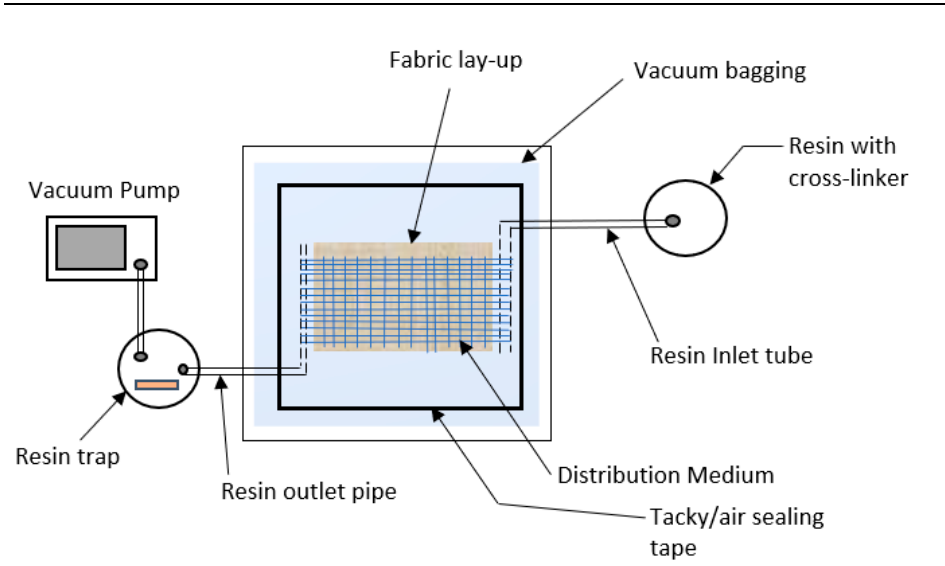
Figure 2. Schematic diagram of vacuum assisted resin transfer molding (VARTM) setup. Table 1. Properties and lay-up of produced inter-ply and intra-ply hybrid composites. Material-1: Inter-Ply Unidirectional Flax-Carbon Hybrid Composites